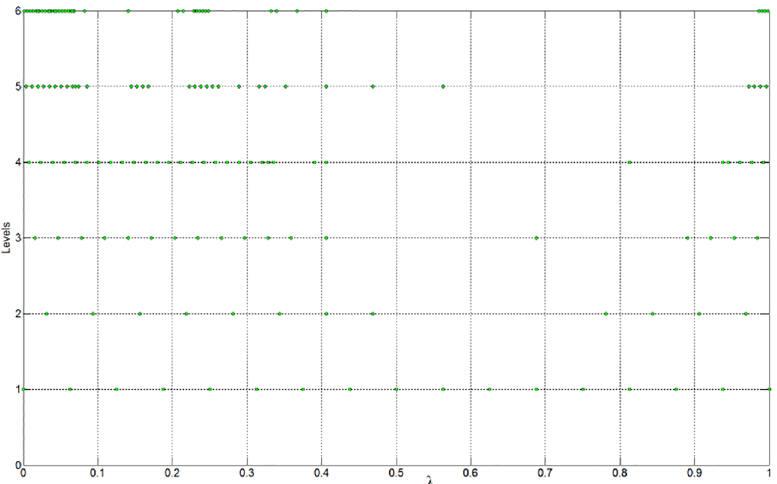
Fig 10. Distribution of the involved collocation points on each level.